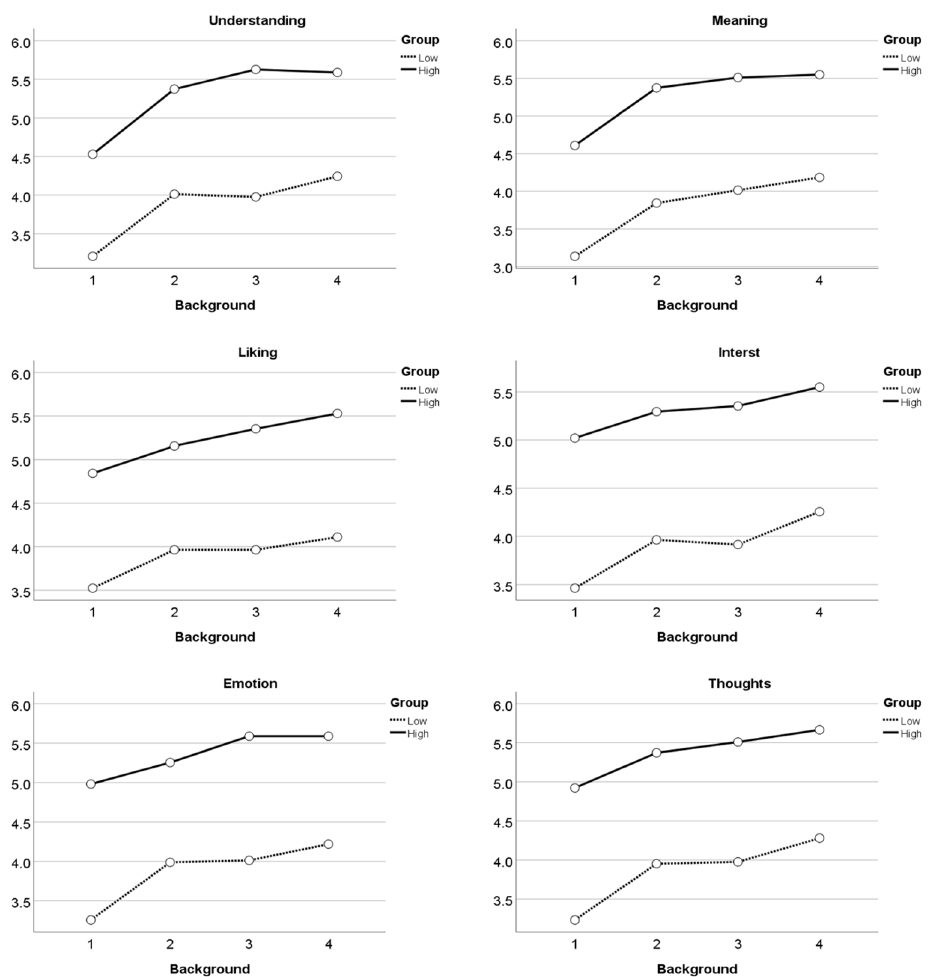
Figure 3. Interactive outline of background information and art interest.